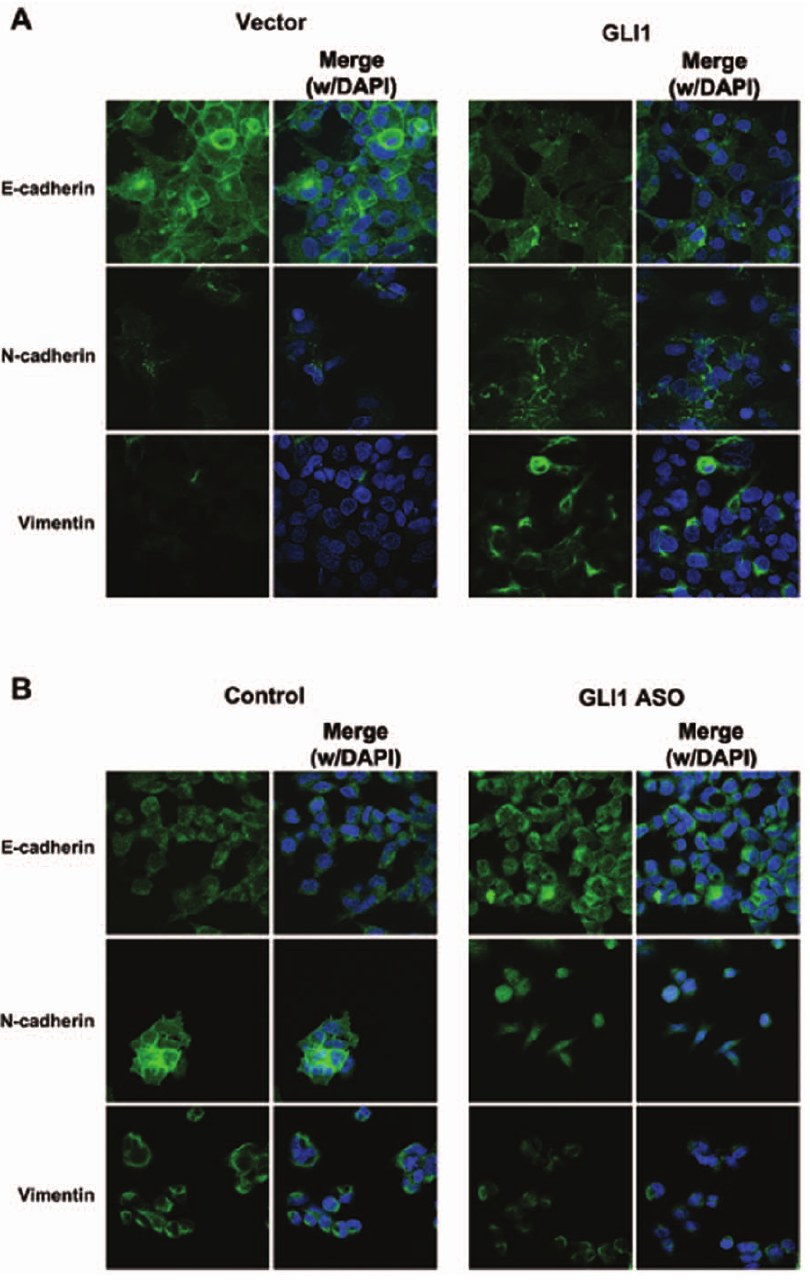
Figure 5. Immunofluorescence studies confirm the role of GLI1 in the regulation of EMT in HCC cells. (A) As assessed by immunofluorescence staining and confocal microscopy, overexpression of GLI1 decreases E-cadherin protein expression and increases the protein expression of both N-cadherin and Vimentin in Huh7 cells. (B) As assessed by immunofluorescence staining and confocal microscopy, knockdown of GLI1 (GLI1 ASO) increases E-cadherin protein expression and decreases the protein expression of both N-cadherin and Vimentin in SNU398 cells. DAPI was used as nuclear staining.